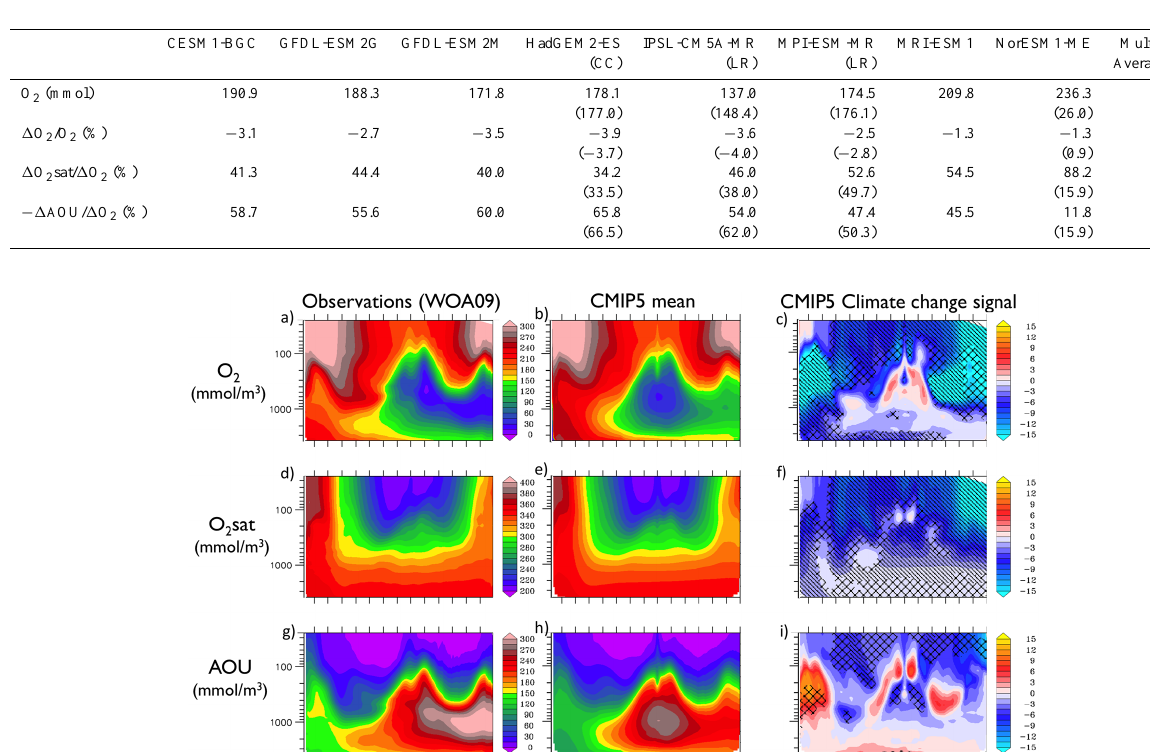
(Fig. 8f) due to 21st century warming, contributing (together with the increase in AOU) to the decrease in oxygen levels in